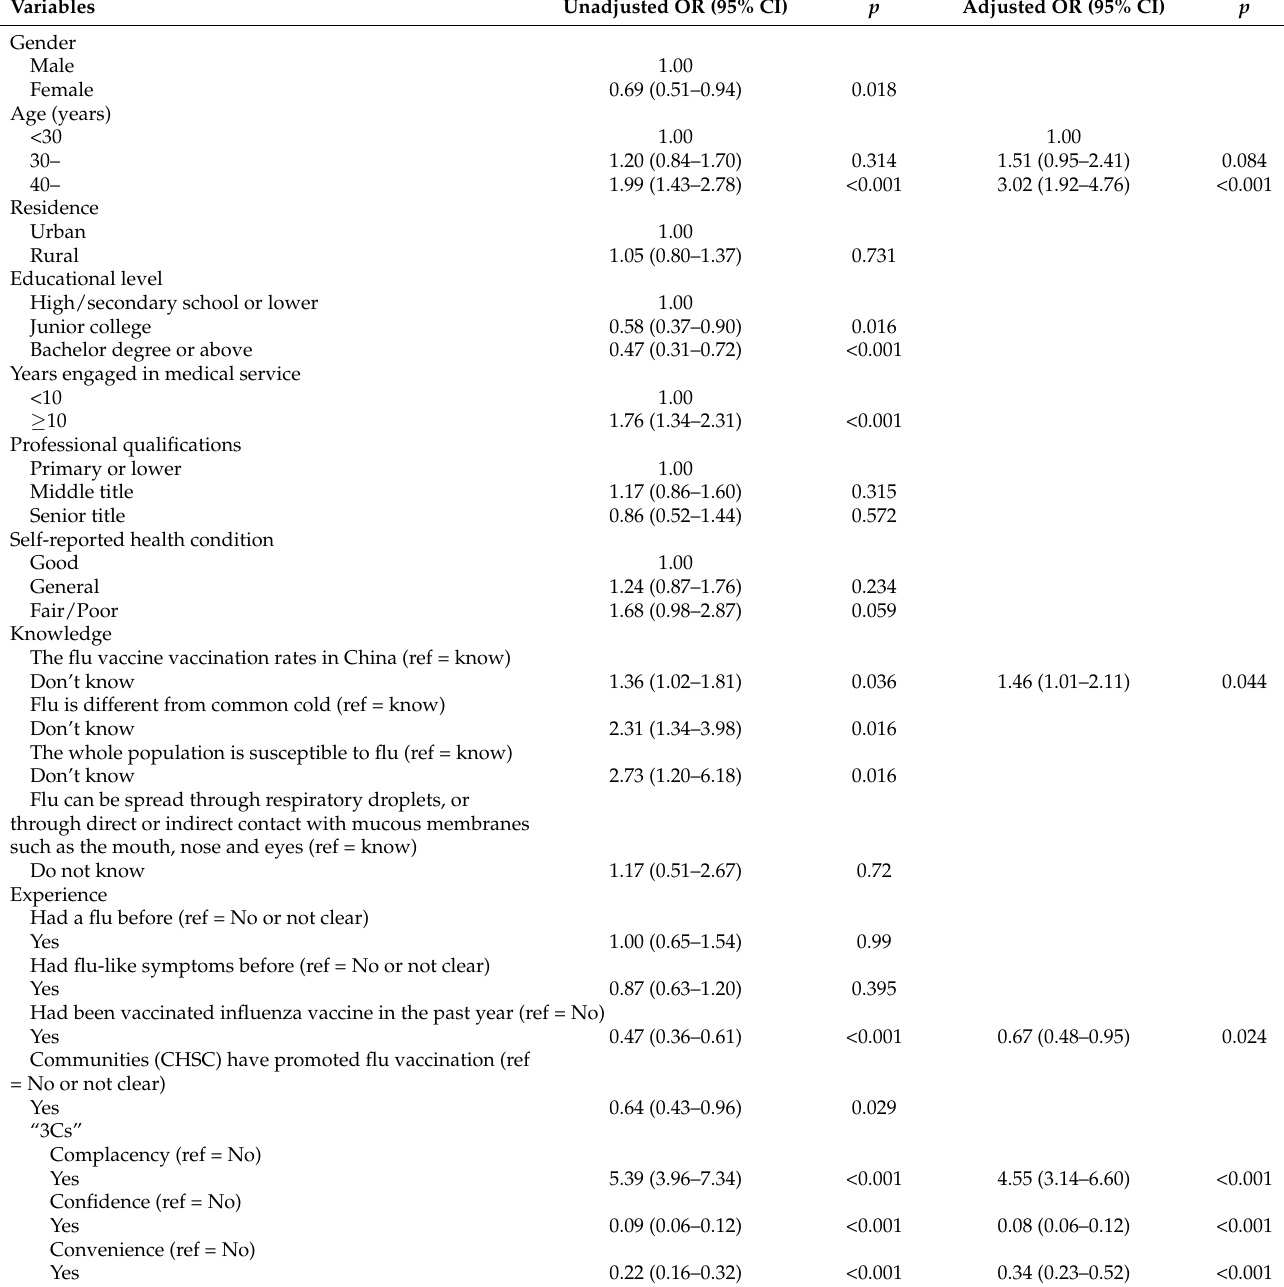
Table 4. Determinants of influenza vaccine hesitancy in community healthcare